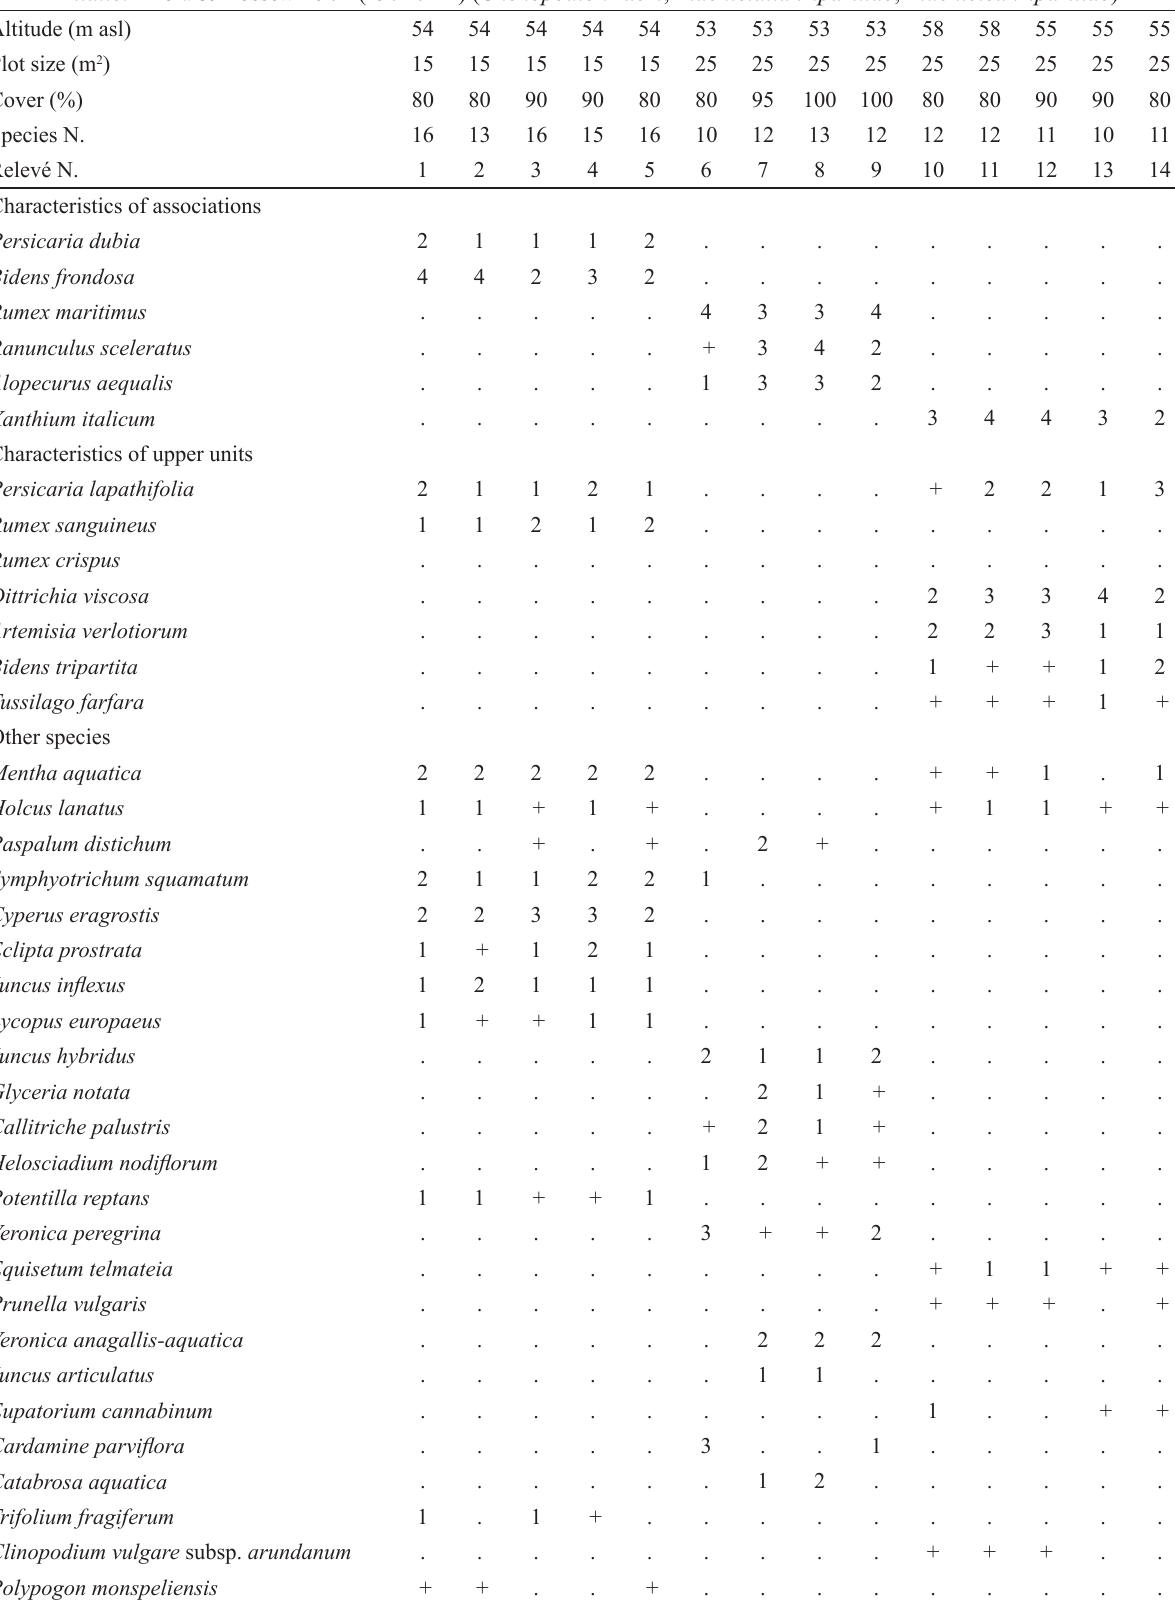
Table 4. Hygro-nitrophylous pioneer vegetation of muddy-sandy river-bed. Bidenti tripartitae-Polygonetum mitis (Roch. 1951) T.Tüxen 1979 var. with Bidens frondosa (rel. 1-5), Rumici maritimi-Ranunculetum scelerati Oberdorfer 1957 (rel. 6-9) ( Bidention tripartitae , Bidentetalia tripartitae , Bidentetea tripartitae ); Polygono lapathifolii-Xanthietum italici Pirola & Rossetti 1974 (rel. 10-14) ( Chenopodion rubri , Bidentetalia tripartitae , Bidentetea tripartitae